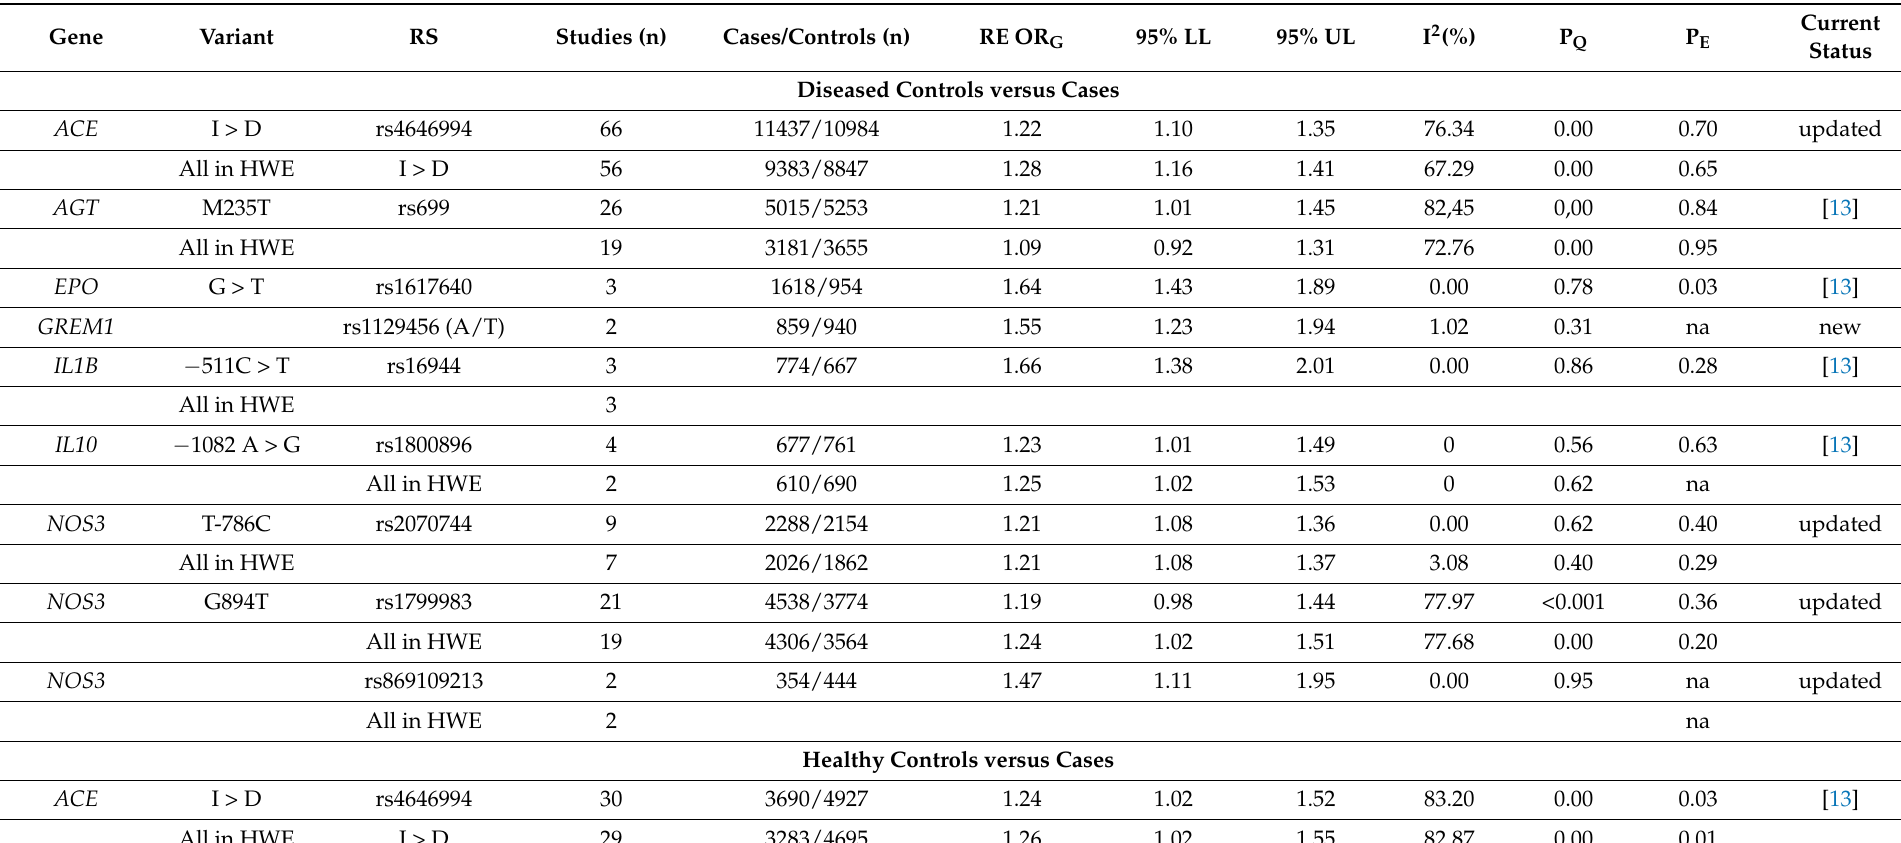
Table 2. Results of the meta-analyses of statistically significant polymorphisms listed in alphabetical order based on genotype counts.